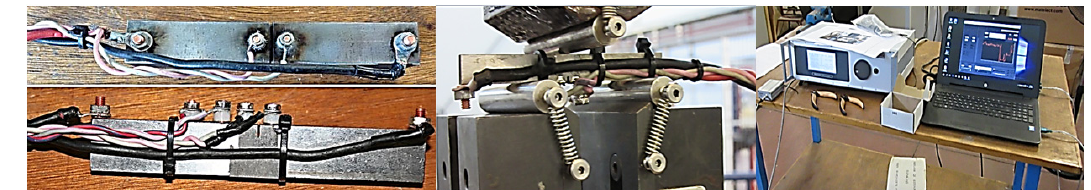
Table 1. Loading characteristics during fatigue precrack stage.